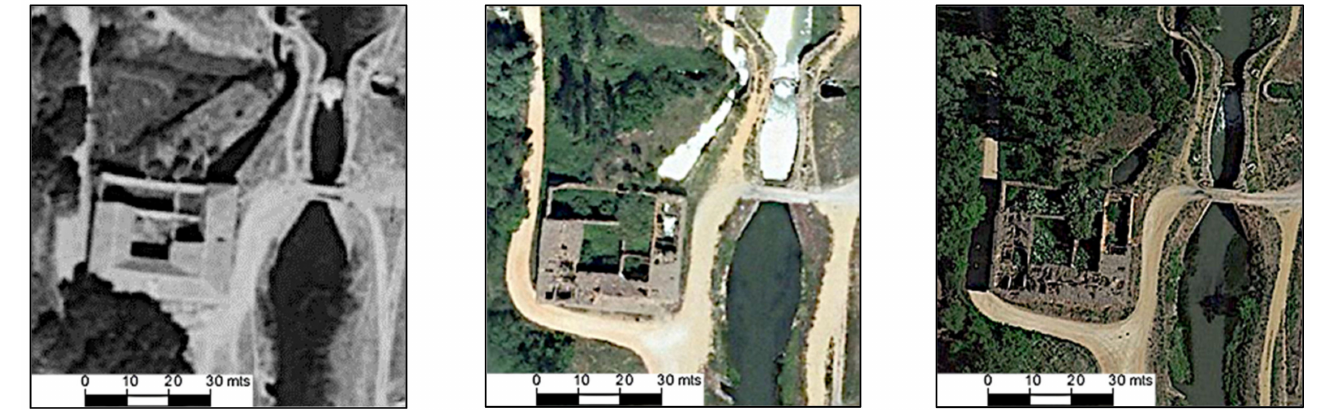
Figure 5. Orthophotos 1977, 2009, and 2021. Source: http://ftp.itacyl.es/cartografia/01_Ortofotograf ia/ (accessed on 2 February